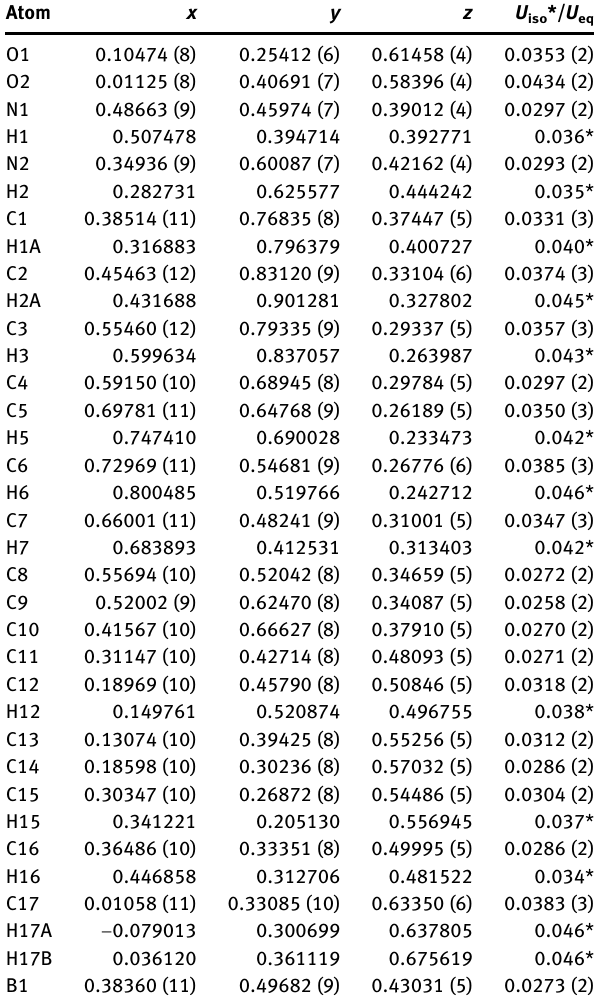
Table  : Fractional atomic coordinates and isotropic or equivalent isotropic displacement parameters (Å 